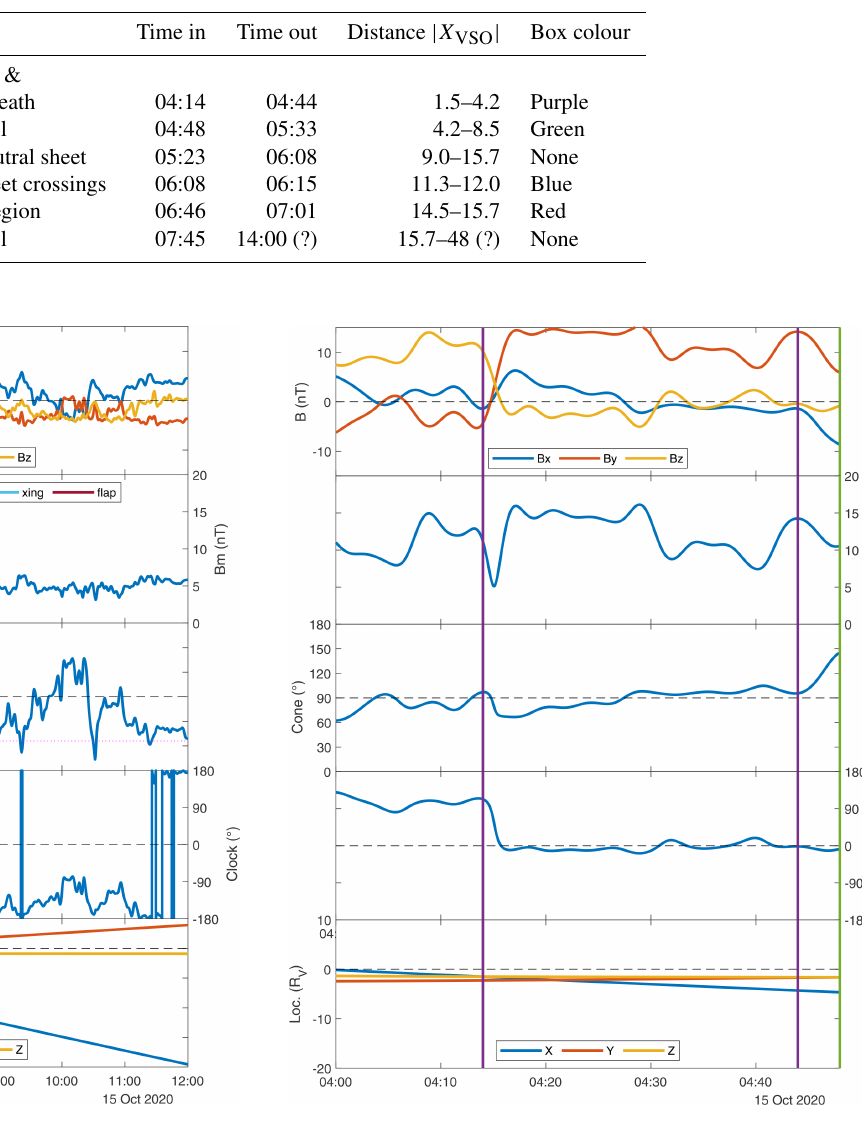
Figure 4. Zoom-in on the magnetosheath interval (purple), where the cone angle θ c ≈ 90 ◦ and the clock angle φ c ≈ 0 ◦ . This indicates that the magnetic field is pointing in the Y VSO